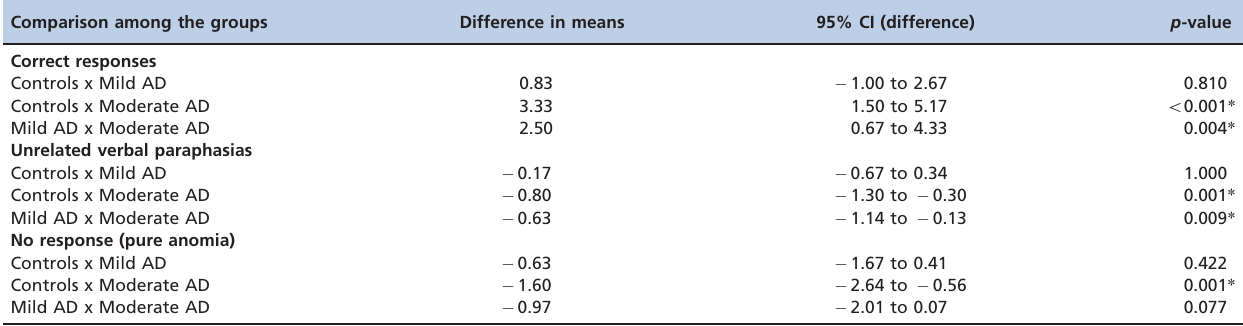
Table 2 – Results of Bonferroni ’ s multiple comparison test for the mean numbers of correct answers, unrelated verbal paraphasias, and no-response errors (pure anomia) for the different groups of